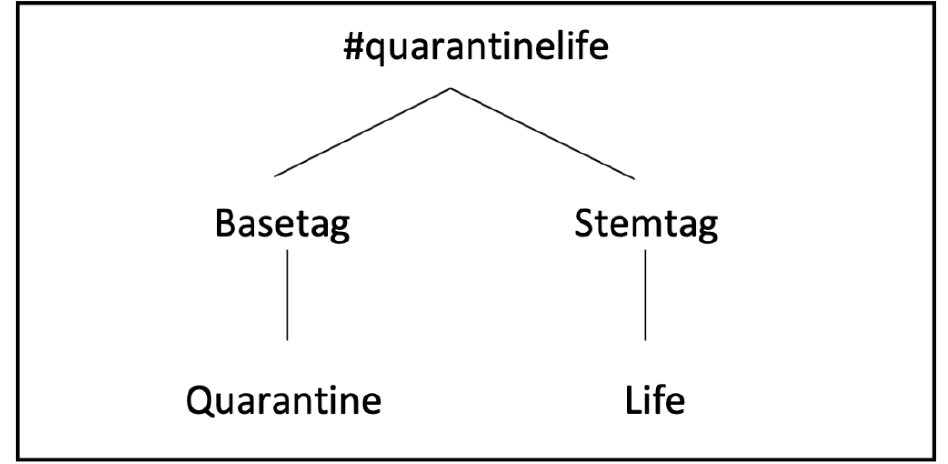
Figure 1. Segmentation of Simple Hashtags